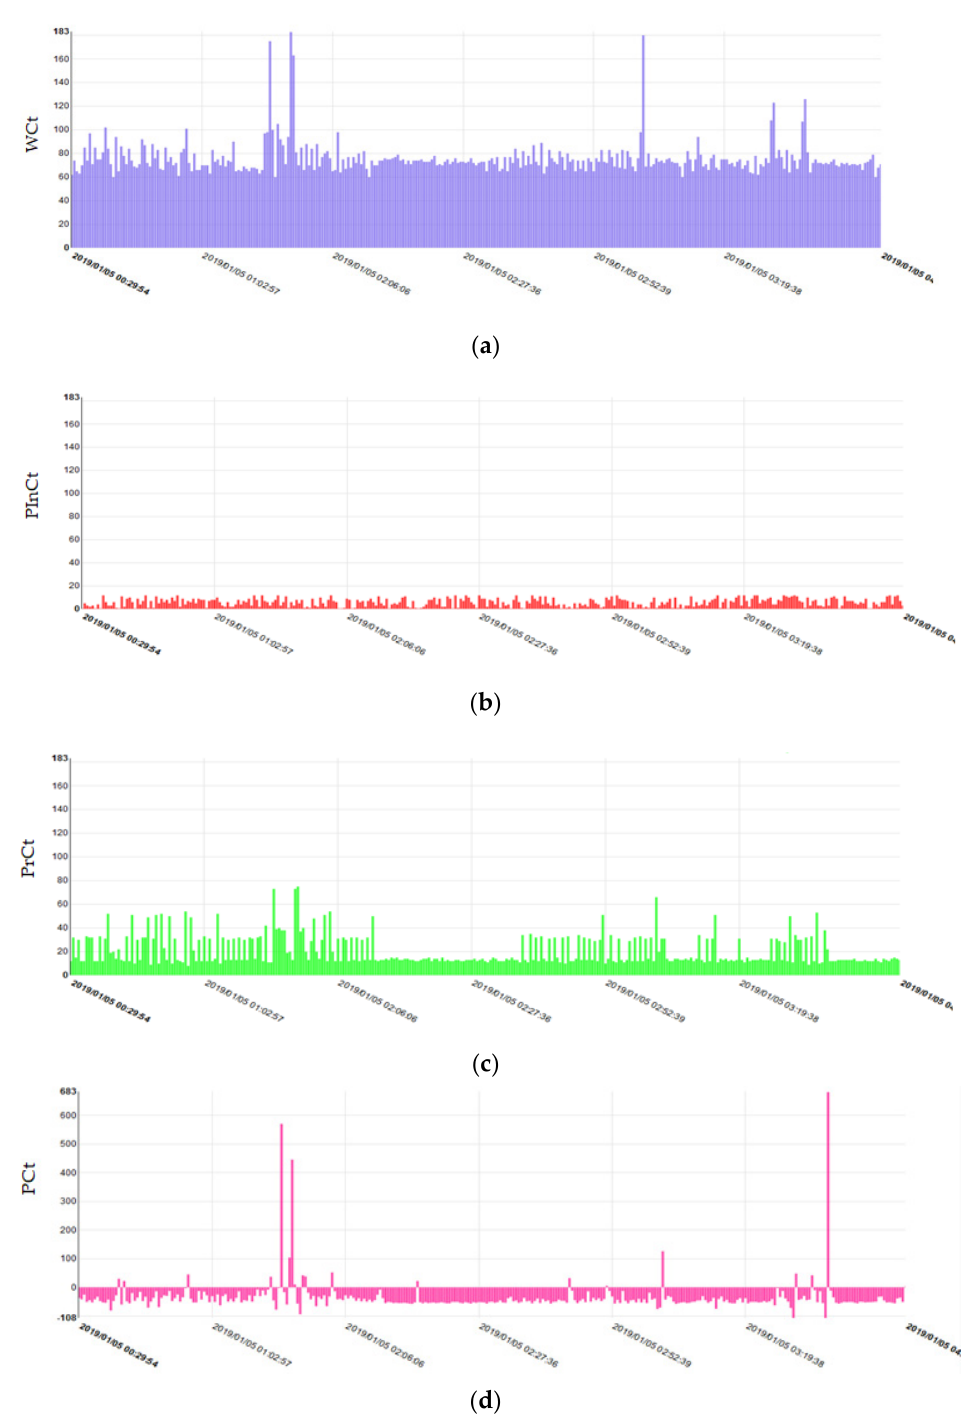
Figure 9. Results of manufacturing cycle time calculation in real-world manufacturing process; ( a ) WCt, ( b ) PInCt, ( c ) PrCt and ( d ) PCt.